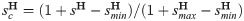
Statistics for the hypergraph H.(a) P(s
H), the distribution of group size s
H, with the distribution in semi-log scale shown in the inset. The two dashed lines in show the range of the tail exponent of P(s
H), namely −3.5 (orange) and −5.0 (magenta). (b) The data collapse of the different broken parts on P(s
H) after re-scaling, in which scH=(1+sH−sminH)/(1+smaxH−sminH), here sminH and smaxH respectively are the minimum and maximum value of s
H in each section, and P
c(s
H) is the corresponding re-scaled probability. (c) The average (pink) and the standard deviation (grey) of group size given specific date of establishment, and the inset shows the scaling relationship between total of groups and total of users at each date. (d) The distribution P(k
H) of the number of joined group by individual users. P(k
H) for male and female users are shown in the inset. The pink lines correspond to power-law fits with exponent −3.82.